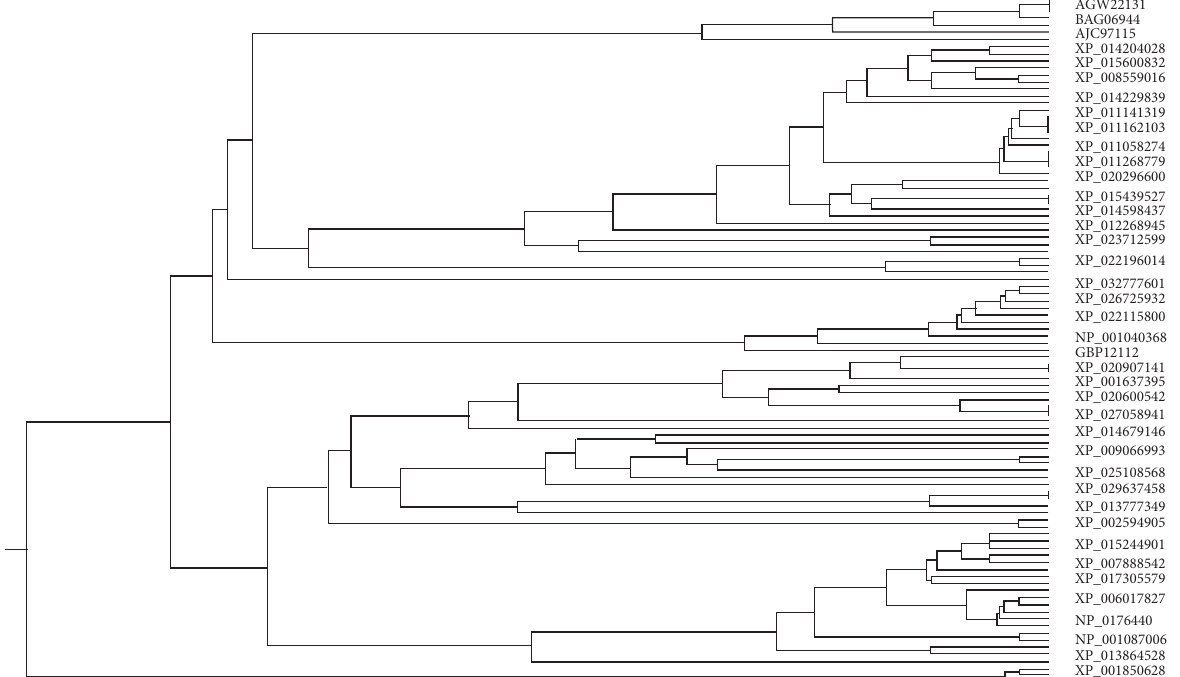
Figure 4: Phylogenetic tree constructed from Rab7 sequences of all groups of organisms (for a clear view all labels are not